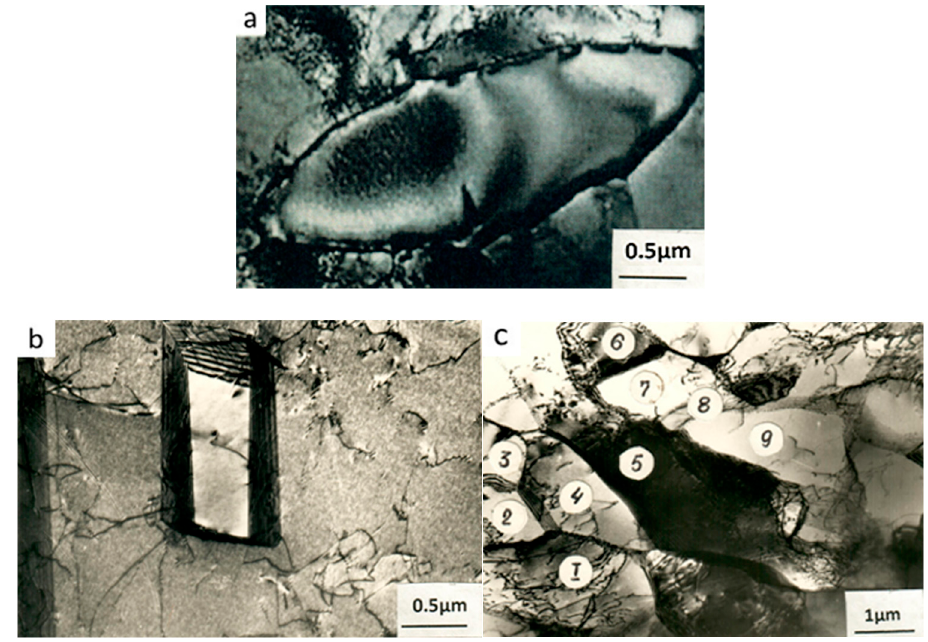
Figure 2. Transmission electron micrographs of Cr-Ni-Ti austenitic stainless steel after one-pass re- duction: ( a ) Nucleus of new grain appearing during dynamic recrystallization, n = 1; ε = 30%; ( b ) nucleus of annealing twin, n = 1; ε = 50%; ( c ) fragmented structure area, n = 1; ε = 50%; 1–9: The same, as shown in numbers 1–6 in Figure 1.